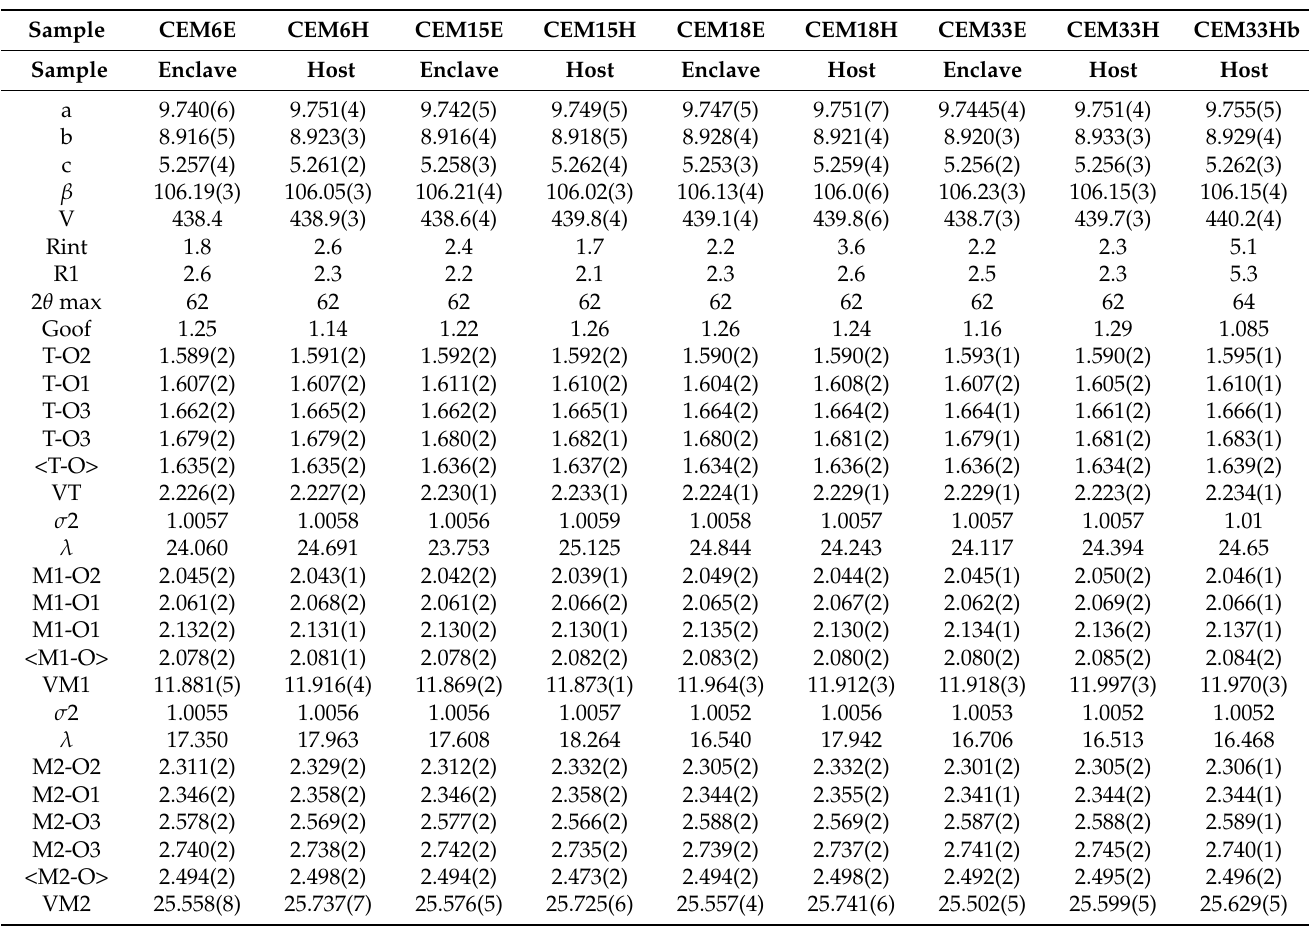
Table 1. Refinement details and crystallographic data for the studied clinopyroxenes. Lattice pa- rameters, bond distances (in Å), polyhedral volumes (in Å 3 ), angle (in degree), site distortions (quadratic elongation, λ and angle variance, σ 2, [41]) are reported. Goof, Goodness of fit; R1, agree- ment factor (in %); Rint agreement factor of equivalent reflections (in %), and N number of unique reflections